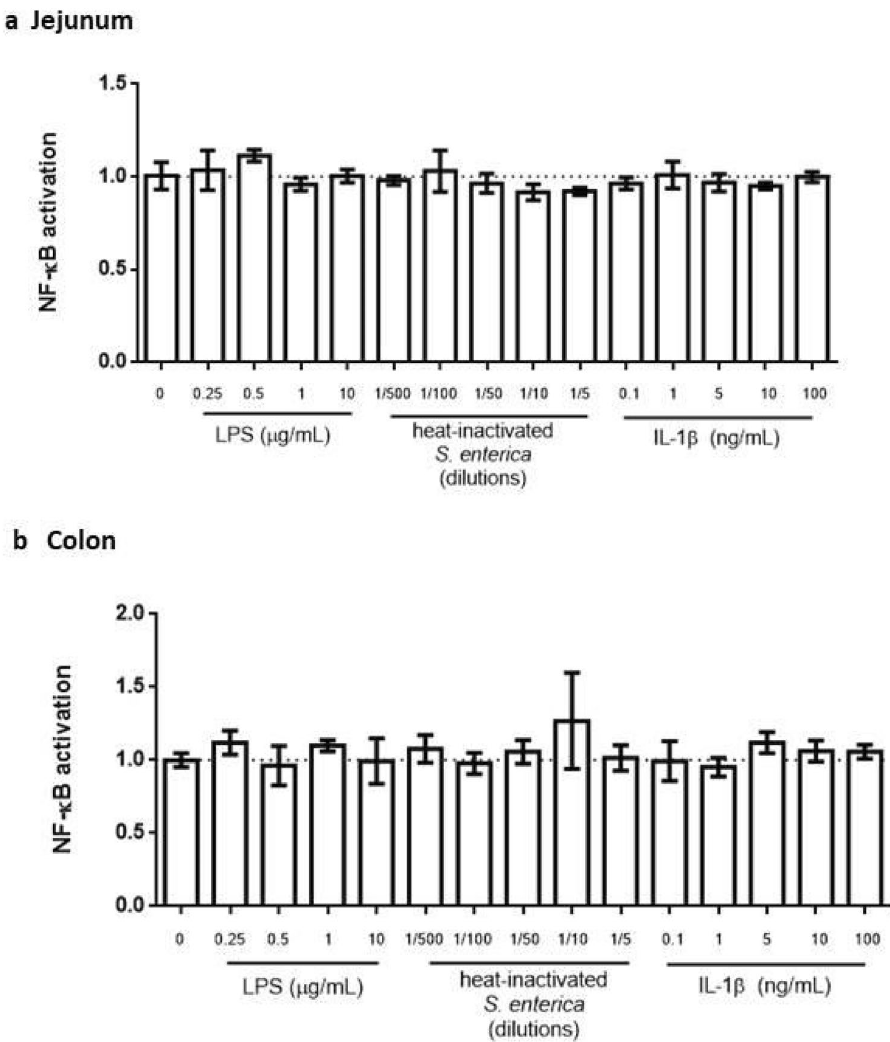
Figure 6. Activation of NF-κB with different proinflammatory stimuli. NF-κB reporter organoids derived from jejunum ( a ) and colon ( b ) were stimulated during 24 h with LPS, IL-1β and heat-inactivated Salmonella enterica . NF-κB activation was determined as previously described. There were no significant differences between the stimulated conditions and the unstimulated group. Data was expressed as mean ± SD of triplicates from one representative